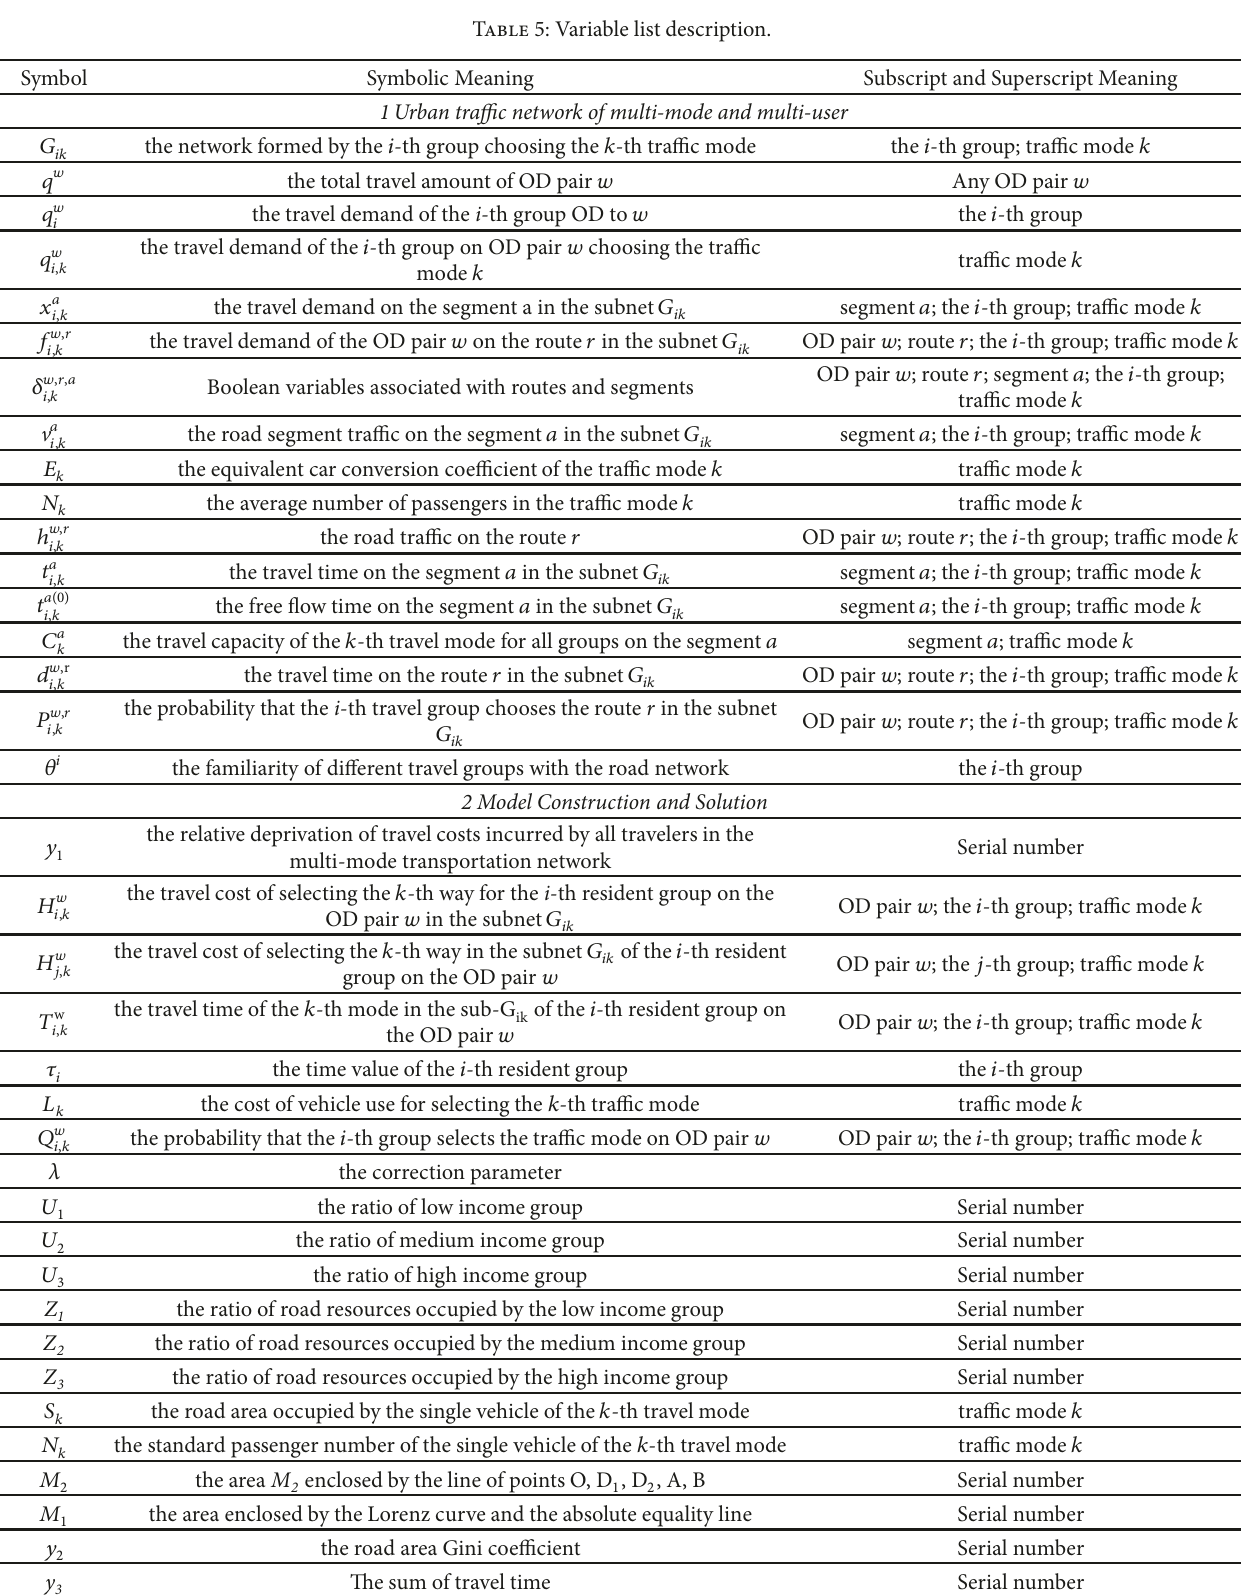
Table 5: Variable list